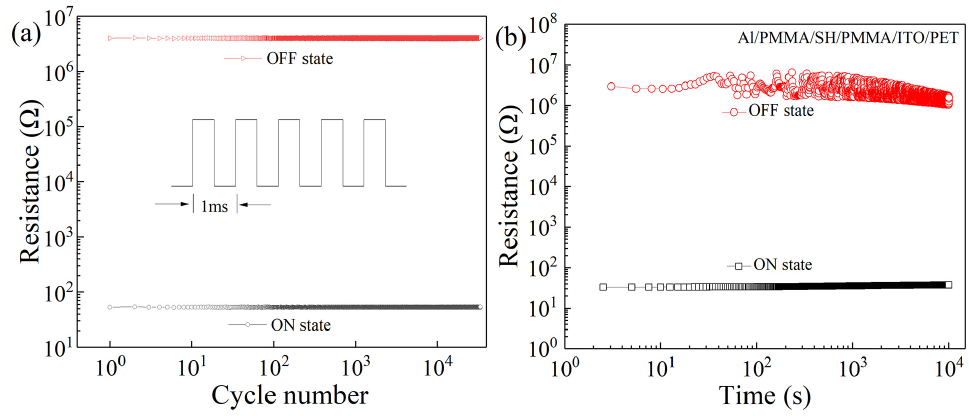
Figure 10. Al/PMMA/SH:GQD/PMMA/ITO/PET device: ( a ) pulse test and ( b ) retention time.